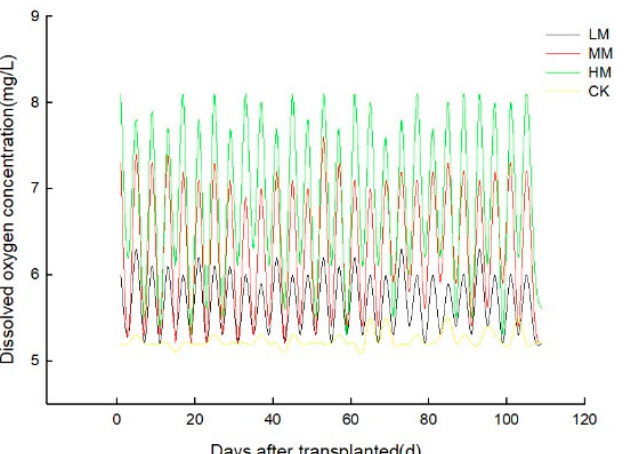
Figure 1. Dissolved oxygen (DO) concentration changes in soil solution under different treatment after rice transplanting. LM, MM, HM, and CK represent low-concentration MNBs, middle-concentration MNBs, high-concentration MNBs, and the ordinary running water, respectively. The same as below.